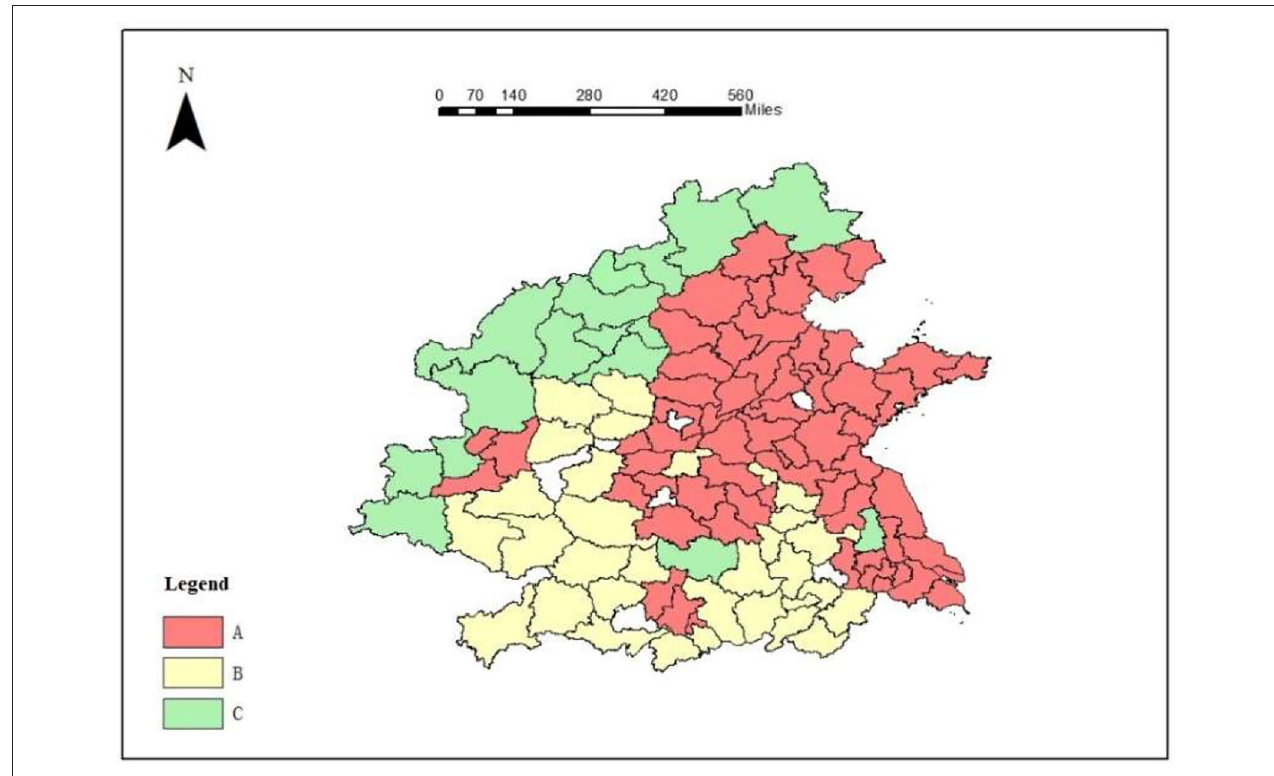
FIGURE 6 | Zoning diagram of the key